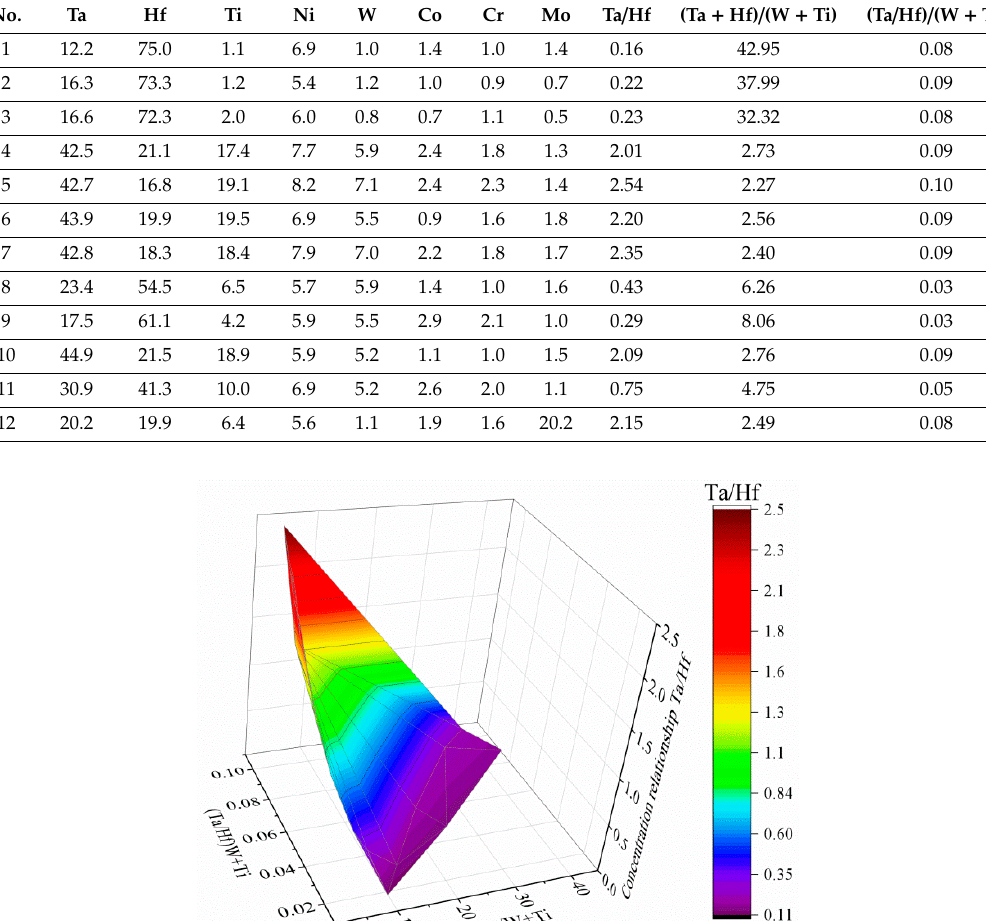
Table 4. Results of SEM-EDX analysis in MC carbides, at%.